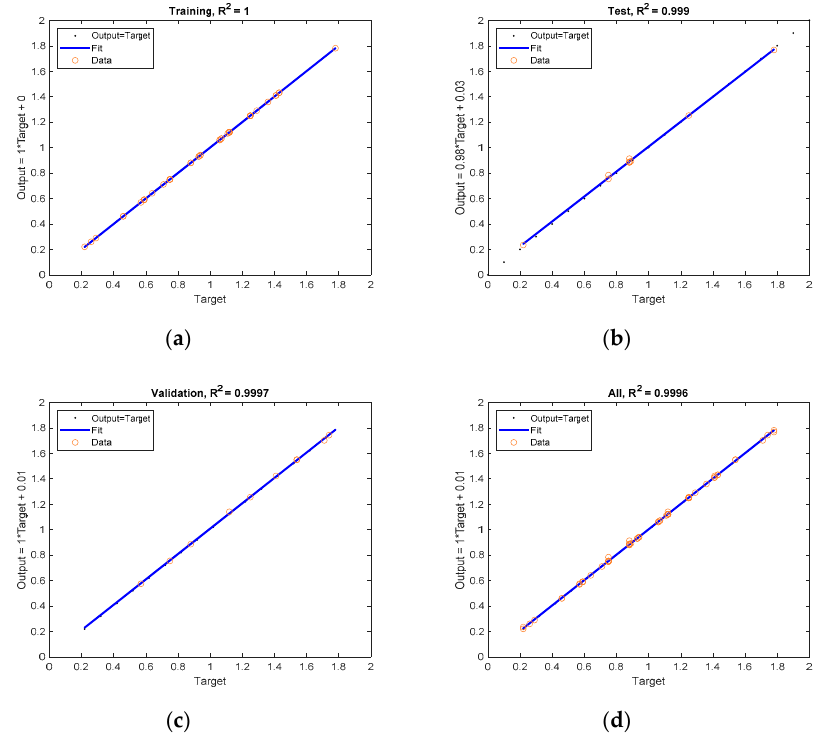
Figure 28. ANFIS results for f 1 . (Number of Epochs = 10, k FIS = 1.16, N FIS = 2.67 ) ( a ) Train data; ( b ) Validation data; ( c ) Test data; ( d ) All data. Table 9. Iteration to find N FIS and k FIS for modeling f 2 function.